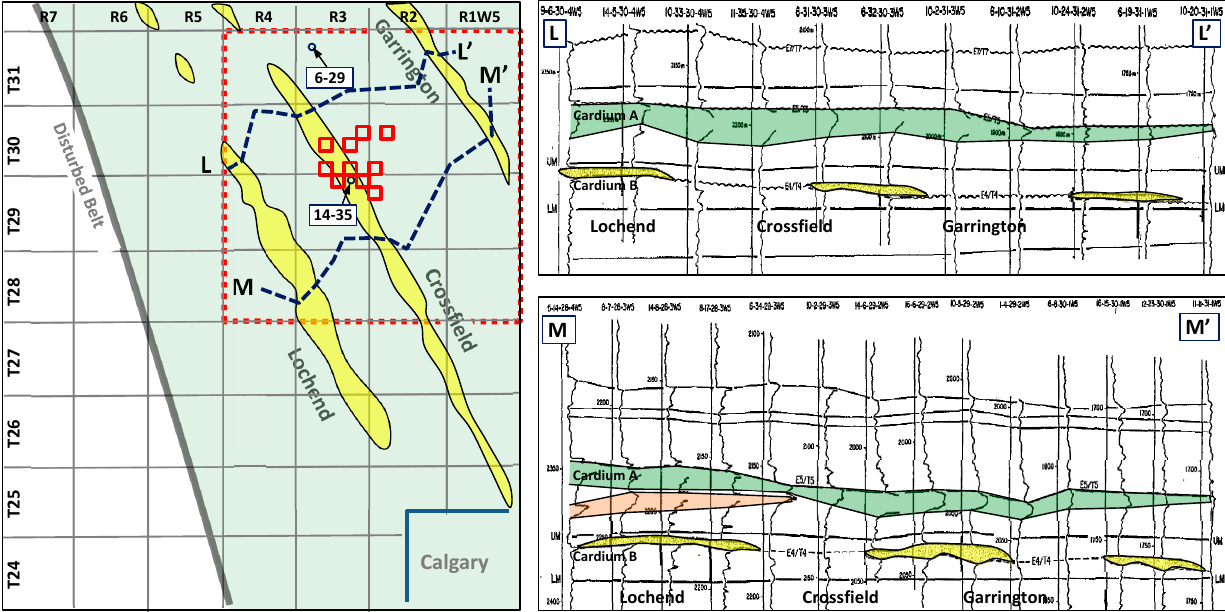
Figure 3. Stratigraphy of Cardium A and B in the study area (modified from Pattison, 1987 [6]).